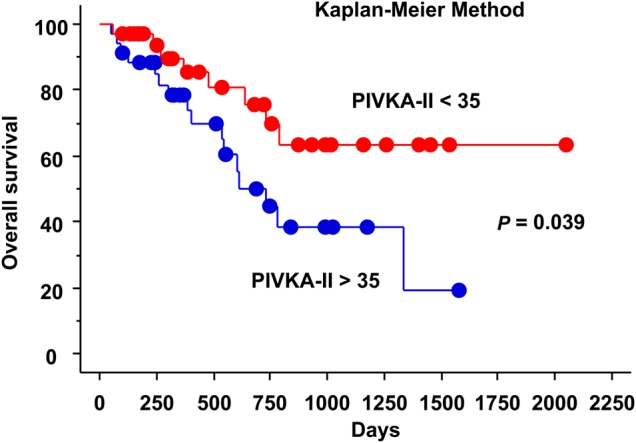
Overall survival curves by serum PIVKA-II value (over 35 vs under 35 AU/ml). There was no patient with serum PIVKA-II level of just 35 AU/ml.